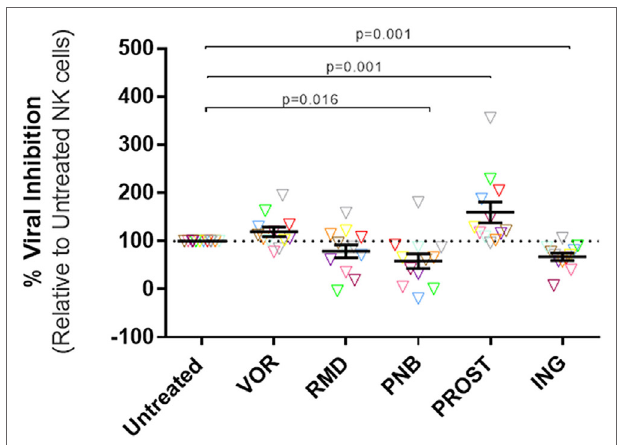
FigUre 1 | antiviral activity of nK cells . Percentage HIV replication inhibition after 7 days of culture, normalized to untreated NK cells. CD4 + T cells were isolated, stimulated, and infected with JR-CSF. Infected targets were cultured with autologous NK cells in triplicate at a ratio 1:1. Each color represents cells from a different donor. At physiologically relevant doses, VOR and RMD did not have significant impact in the antiviral activity of the NK cells, while exposure to PNB and ING impaired NK cell viral inhibition capacity. On the contrary, NK treatment with PROST improves antiviral activity of NK cells. p -values were calculated using a Wilcoxon matched-pairs signed rank test. N = 12. VOR, vorinostat; RMD, romidepsin; PNB, panobinostat; PROST, prostratin; ING,